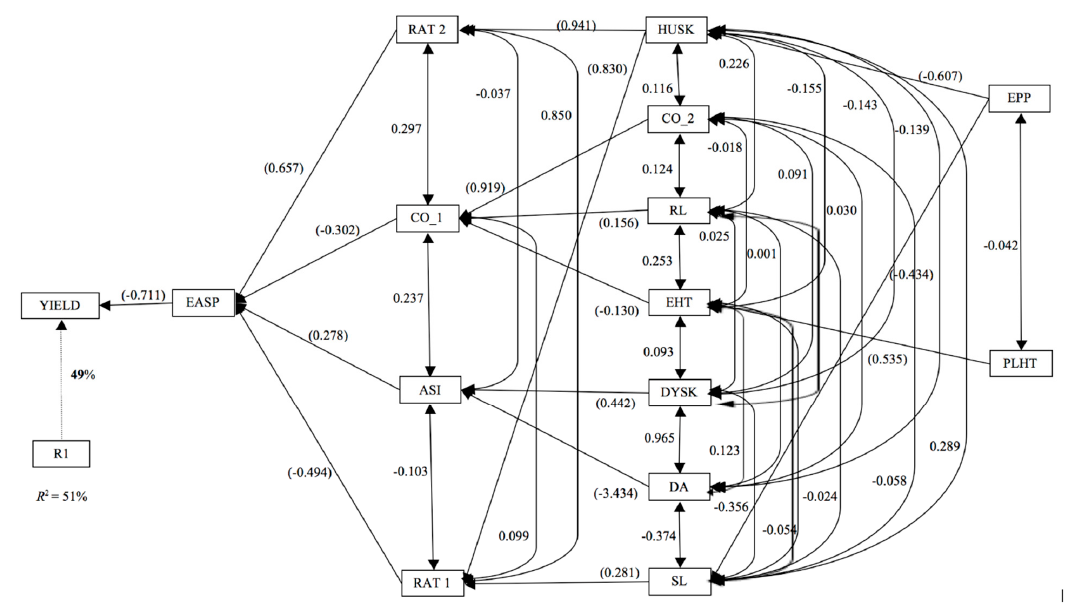
Figure 4. Path analysis diagram displaying the relationship of traits under Striga infestation. Note: Values written in bold are the error effects; the direct path coefficients are values in parenthesis and other values are correlation coefficients. R1 is error effects; YIELD: grain yield; DA: Days to 50% anthesis; DYSK: Days to 50% silking; ASI: Anthesis-silking interval; PLHT: Plant height; EASP: Ear aspect; EPP: Ears per plant; HUSK: Husk cover; PASP: Plant aspect; EHT: Ear height, RAT 1 and RAT 2: Striga damage score at eight and 10 WAP, respectively; CO_1 and CO_2: Number of emerged Striga plants at eight and 10 WAP, respectively; RL: Root lodging; SL: Stalk lodging.